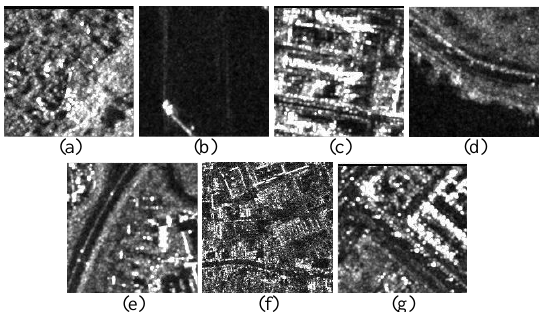
Figure 1: EO data set of 1230 SAR images grouped in seven non- equal size classes. (a) forest, (b) water, (c) medium density urban area, (d) forest + water, (e) roads, (f) high density urban area, and (g) urban area +